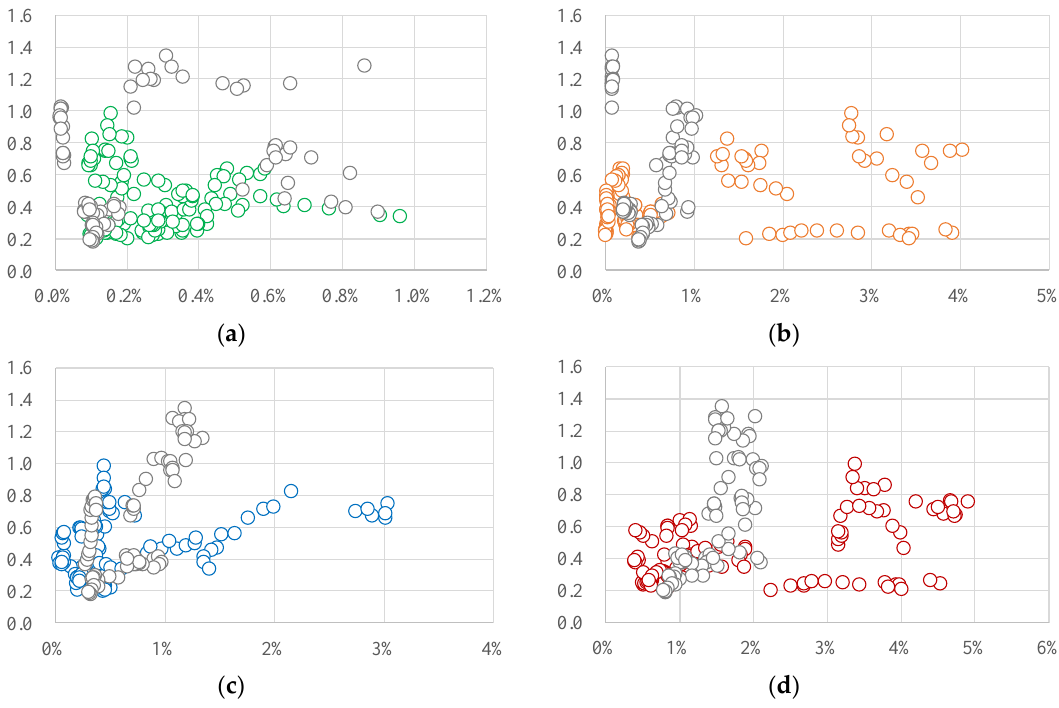
Figure 4. The scatter plot of capital productivity (CP) and ICT capital share. ( a ). IT capital share; ( b ). CT capital share; ( c ). Software capital share; ( d ). Share of total ICT capital. Note: The vertical axis shows the CP and the horizontal axis shows the capital share in gross capital stock. Grey color represents countries with a large economic scale.